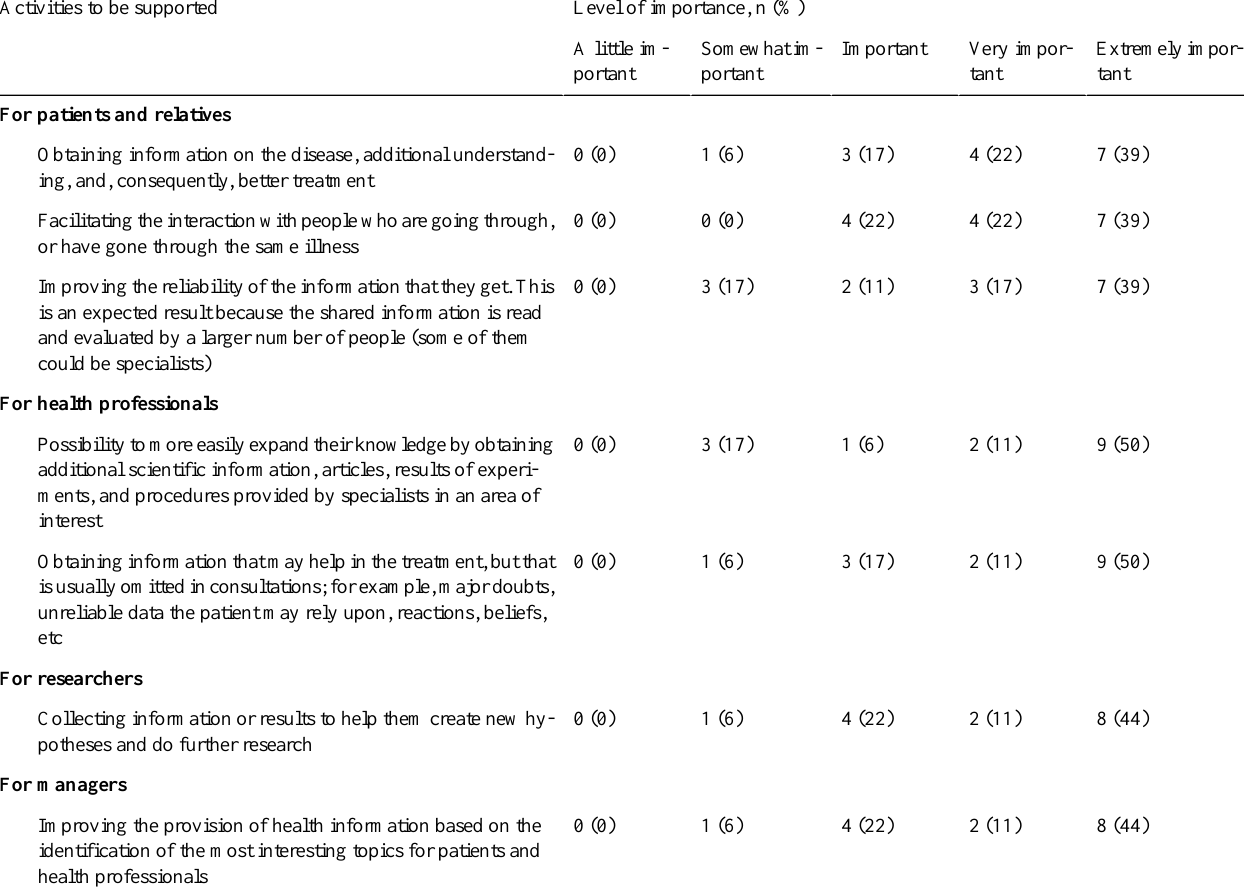
Table 8. Importance of the integrated MEK-EDIPS tool in the health scenario.